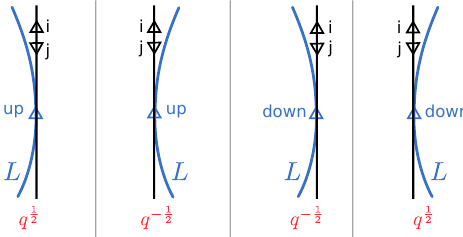
Figure 16 . Tangency factors contributing to the overall weight α ( e L ) . The black line denotes a WKB leaf of type ij . Here the word “up” or “down” next to a segment of L indicates the behavior in the R -direction, which is perpendicular to the h